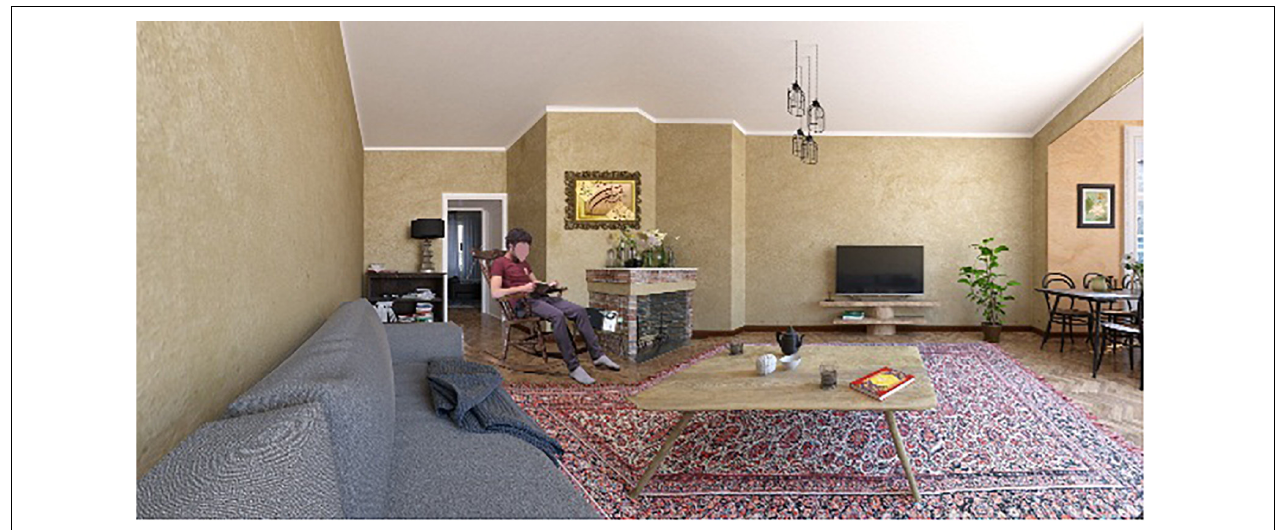
FIGURE 1 | The simulated environment used in this